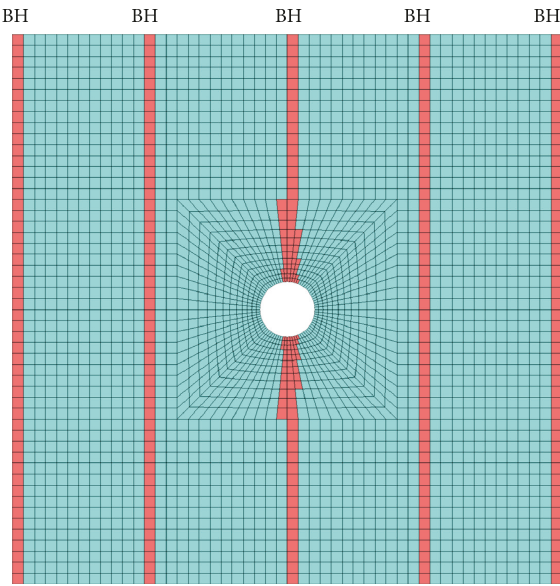
Figure 3: Supposed borehole locations and exposed Table 1: Deterministic input parameters for the hypothesized tunnel.